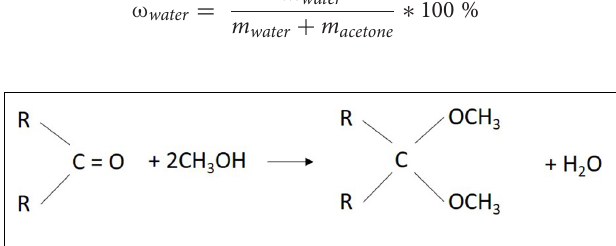
FIGURE 3 | Side reaction of aldehydes or ketones with methanol during Karl Fischer titration. Forming water can falsify the results of water